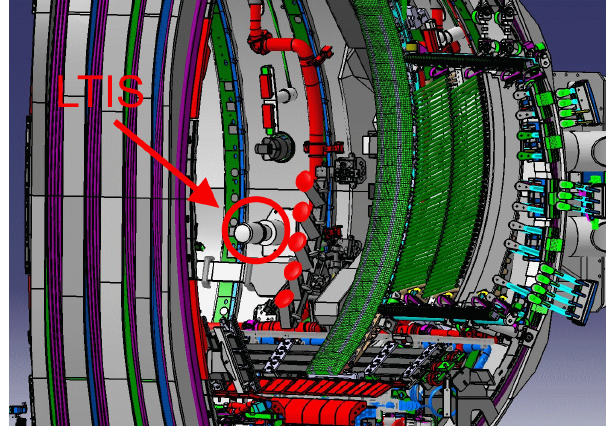
Fig. 1 CAD model of the LTIS position in the JET tokamak. The LTIS is located in the 7 th octant below the middle plane of the tokamak.